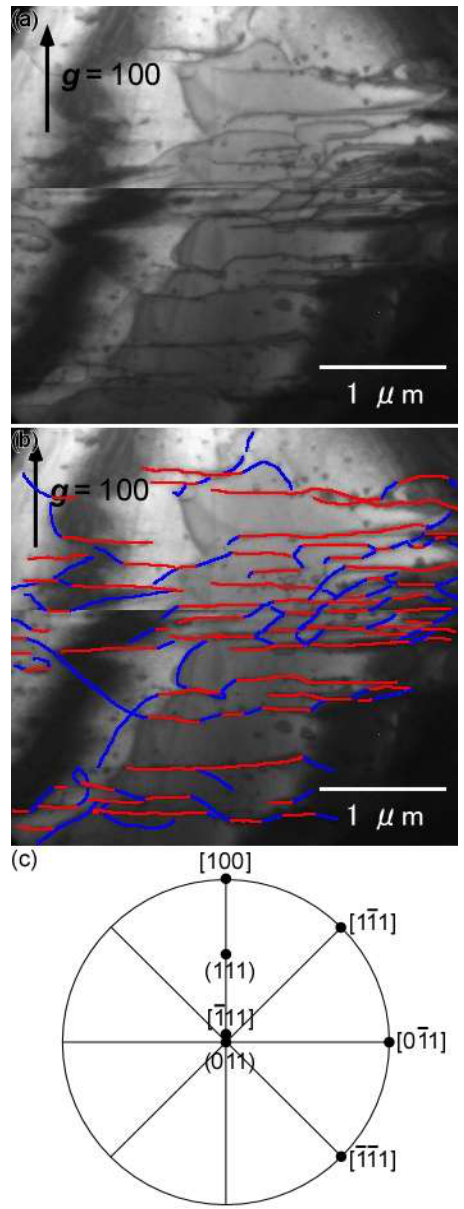
Figure 4. ( a ) TEM bright-field images obtained from the (011) specimen cut out from the deformed sample; ( b ) the same images as in ( a ). Dislocations along the [011] direction are indicated by red lines and dislocations that deviate from the [011] direction more than 10 ° are indicated by blue lines; ( c ) stereographic projection of Bi 1− x Sb x .